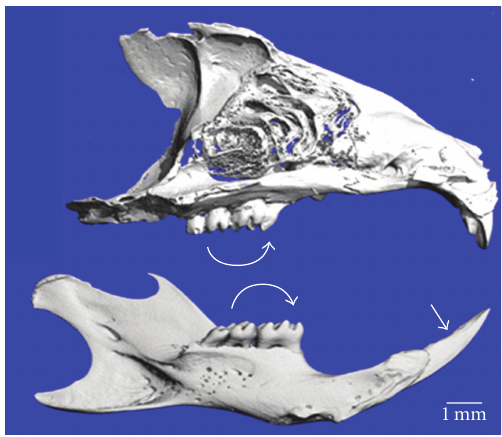
Figure 1: Micro CT images of mouse maxilla (top) and mandible (bottom) show 3 molars (curved arrow) and single incisor (arrow- head). Courtesy of HS. Oz and DA. Puleo (unpublished